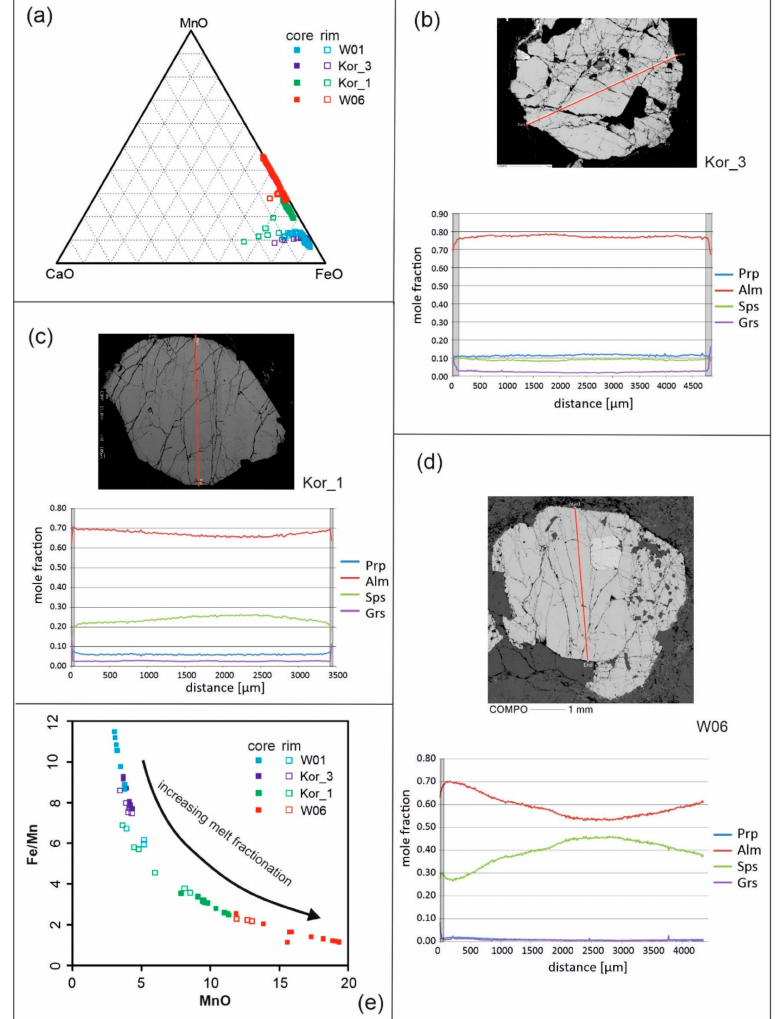
Figure 3. ( a ) Ternary diagram of garnet major element chemistry indicating garnet cores (filled squares) as almost almandine-spessartine solid solutions. Note that the rim zones (open squares) show an increase in the CaO component. ( b – d ) Major element profiles from garnet of sample Kor_3 ( b ), sample Kor_1 ( c ), and sample W06 ( d ). Note the variable Mn content between the profiles and a trend towards higher XMn concentrations that goes along with the increasing grade of melt fractionation shown in ( e ). In all garnets, small outermost rim zones were defined by a “jump” in the XCa concentration (grey fields). The garnet of sample Kor_3 is shown in Figure 2g, and the garnet of sample W06 is shown in Figure 2h. The garnet of sample W06 shows a “spessartine bell-shaped profile”. Red line indicates profile direction. ( e ) The MnO (wt.%) vs. Fe/Mn (molar) plot indicates the grade of melt